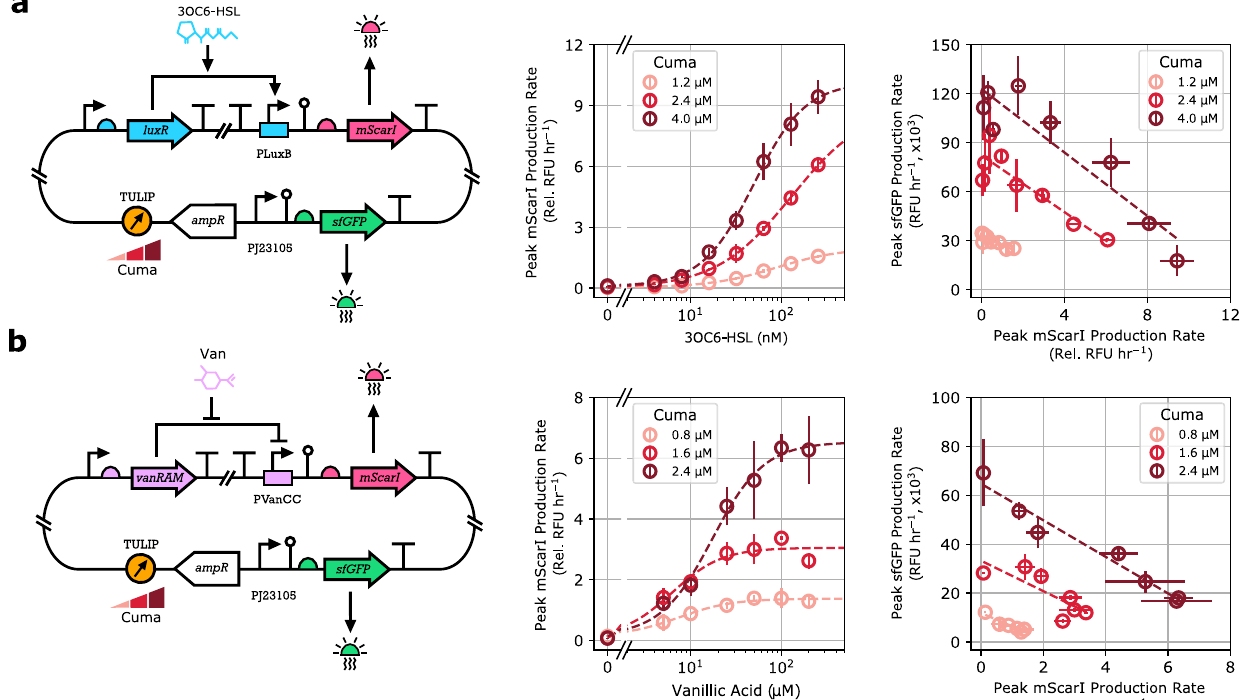
Fig. 5 | TULIP accelerates the design and optimization of genetic modules via fl exible PCN control. All experiments were performed in DH10B. Light, medium, and dark red denote the varying Cuminic acid levels used to modulate PCN. Pro- duction of mScarI is normalized to DHScarI, a strain constitutively expressing mScarI, thus mScarI production is reported as a relative ( “ Rel. ” ) value. a The AHL-